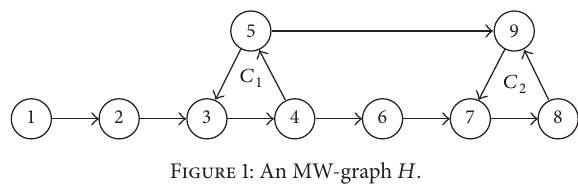
Figure 1: An MW-graph 𝐻